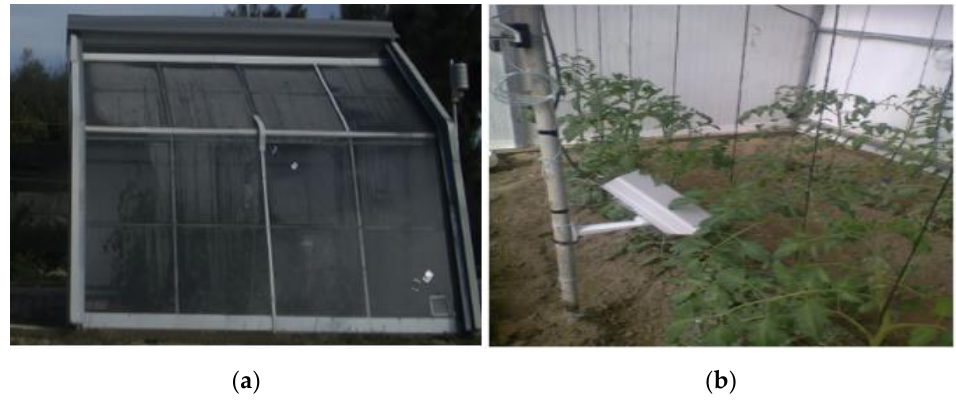
Figure 8. ( a ) Greenhouse; ( b ) Greenhouse internal area with tomato